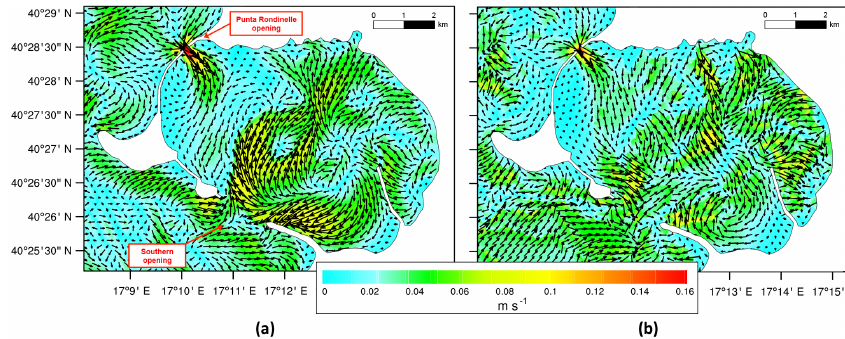
Figure 15. Surface (a) and bottom (b) circulation of SANIFS in Mar Grande of Taranto for 5 October 2014 (CHS).